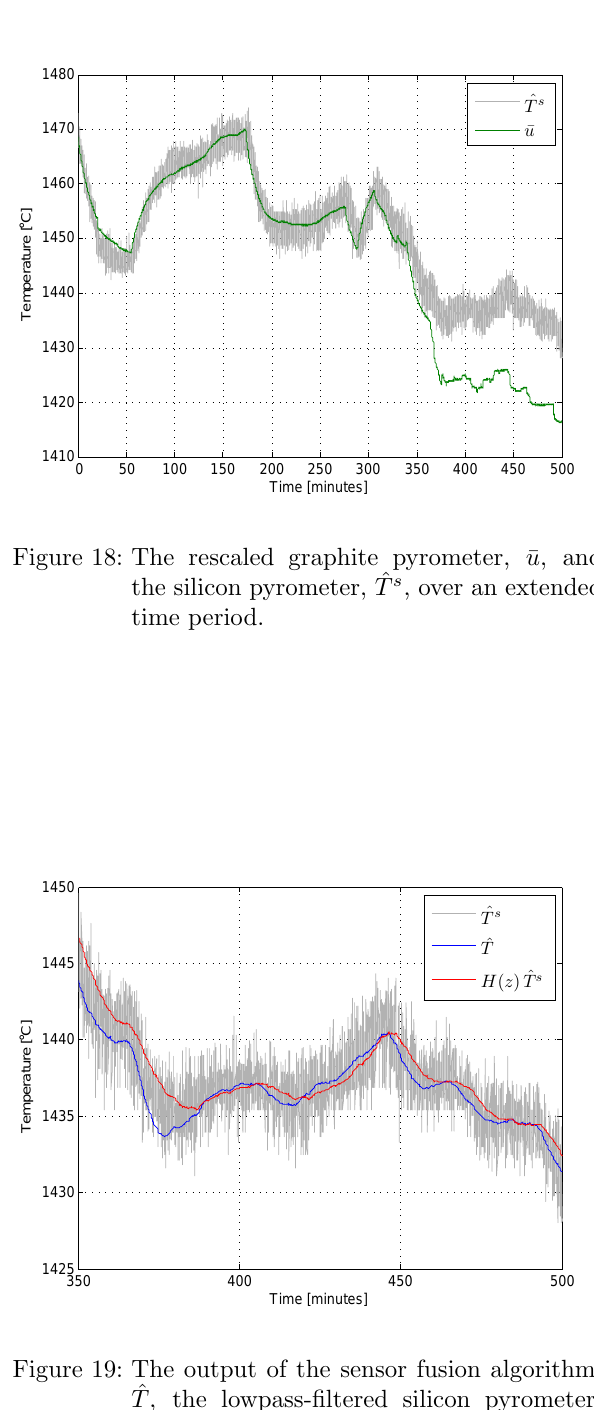
Figure 19: The output of the sensor fusion algorithm, ˆ T , the lowpass-filtered silicon pyrometer, H ( z ) ˆ T s , and the unfiltered silicon pyrome- ter, ˆ T s , over an extended time period.